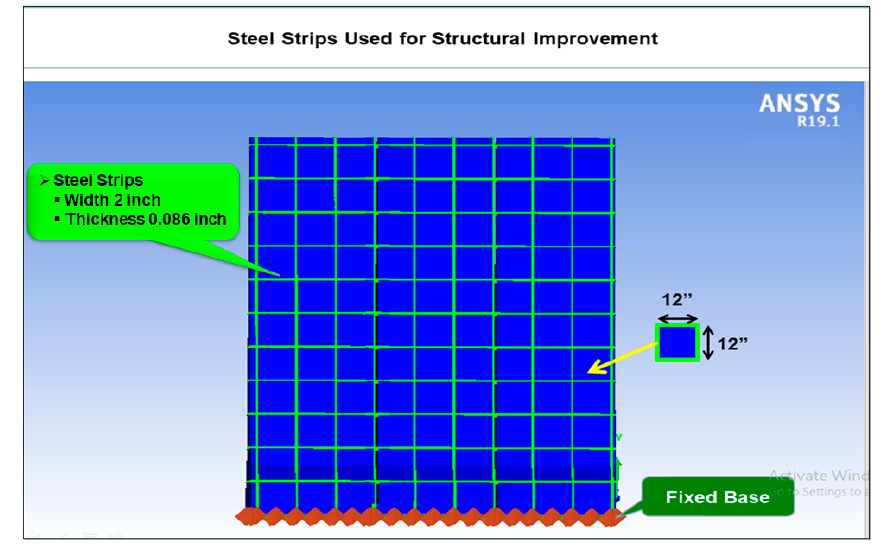
Figure 6. Steel strips modelled as a strengthening technique for structural improvement.